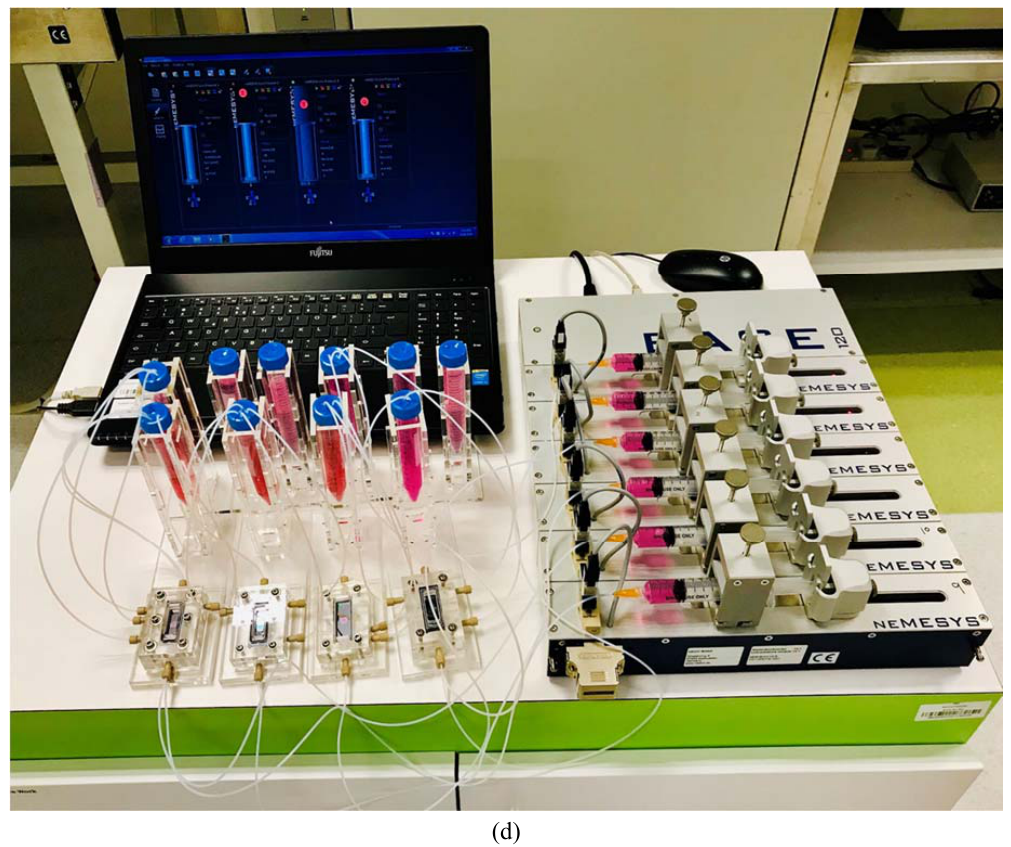
Figure 3. ( a ) The major fabrication processes of the microfluidic chips demonstrated in 3D drawing. ( b ) The process details in a cross ‐ sectional view. ( c ) A schematic drawing of the fluidic set ‐ up and perfusion circuit. The perfusion circuit inside the cell culture incubator while the driving pump is located outside the incubator. ( d ) An overview image of the perfusion circuit.